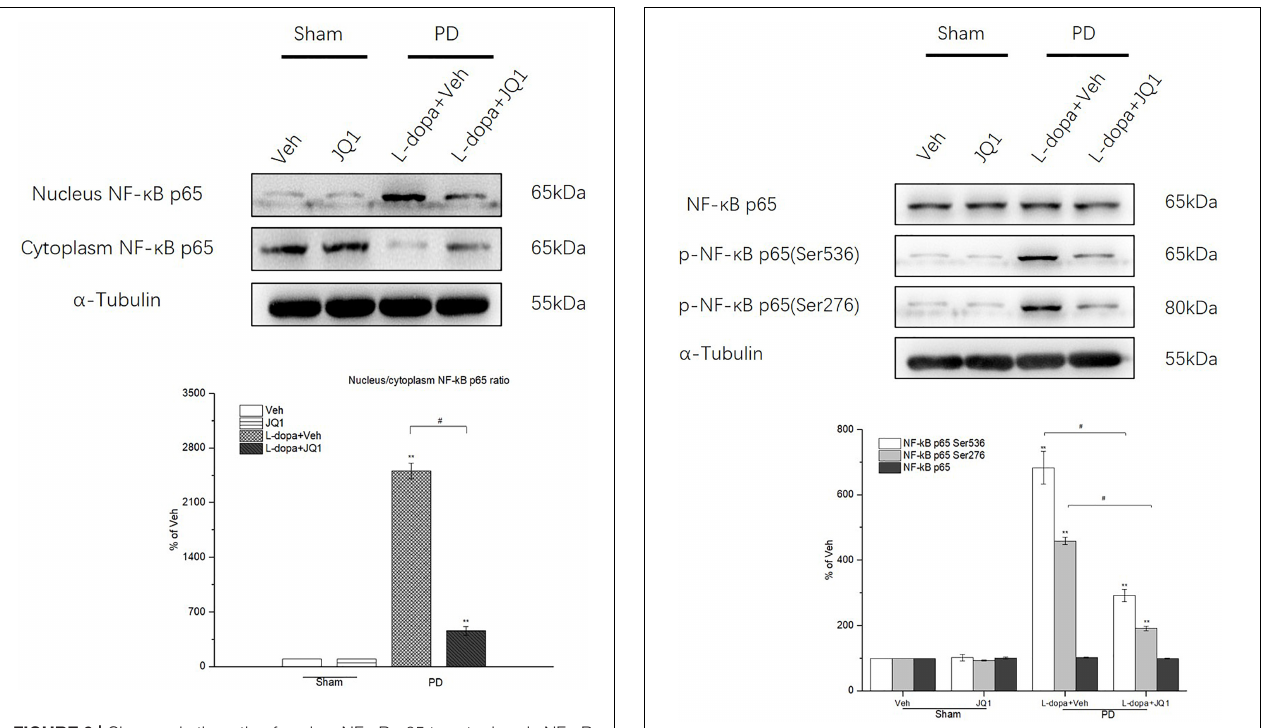
FIGURE 10 | Changes in the expression of NF- κ B p65 and its phosphorylation (Ser 536, Ser 276) extracted from the saline- or 6-OHDA-lesioned striatum after 21 days of administration. Both the L-dopa group and the L-dopa + JQ1 treatment groups showed an aberrant increase in the protein level of phospho-NF- κ B p65 (Ser 536 and Ser276) in the 6-OHDA-lesioned striatum of rats after 21 days of treatment ( p < 0.001 vs. Veh group). Moreover, the increase in phospho-NF- κ B p65 at the two sites in the L-dopa treatment group was greater than in the L-dopa + JQ1 treatment group ( p < 0.01). In addition, JQ1 barely affected the expression of phospho-NF- κ B p65 (Ser 536 and Ser276) in the saline-lesioned striatum in JQ1 treatment group ( p > 0.05 vs. Veh group). The NF- κ B p65 protein level remained unchanged among the four treatment groups. All the aforementioned protein levels expressed relative to α -tubulin levels. The data are expressed in terms of mean ± SD and as a percentage of the Veh group, ** p < 0.001 vs. Veh group, # p < 0.01 vs. L-dopa treatment group ( n = 3 per